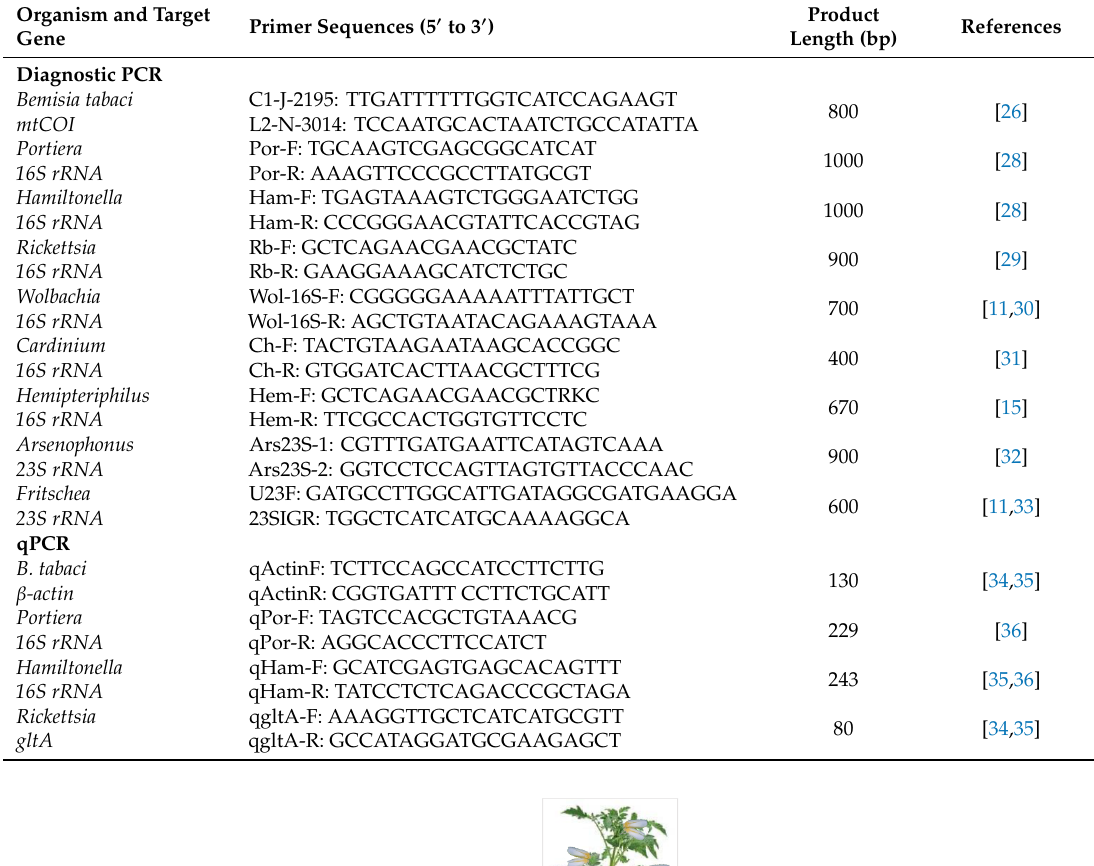
Table 1. Primers used for symbiont identification and quantification.